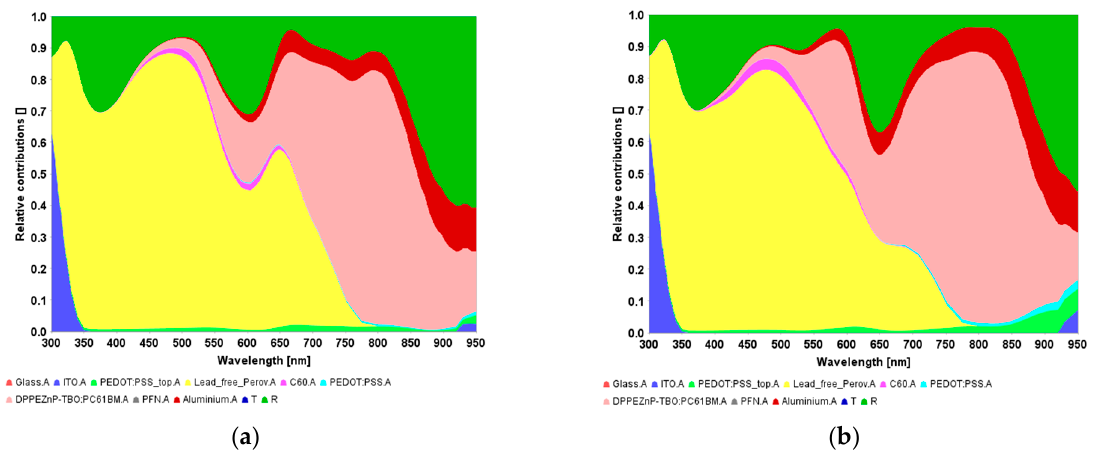
Figure 7. Resolved absorptance spectra as obtained from ( a ) optical simulation and ( b ) coupled simulations.